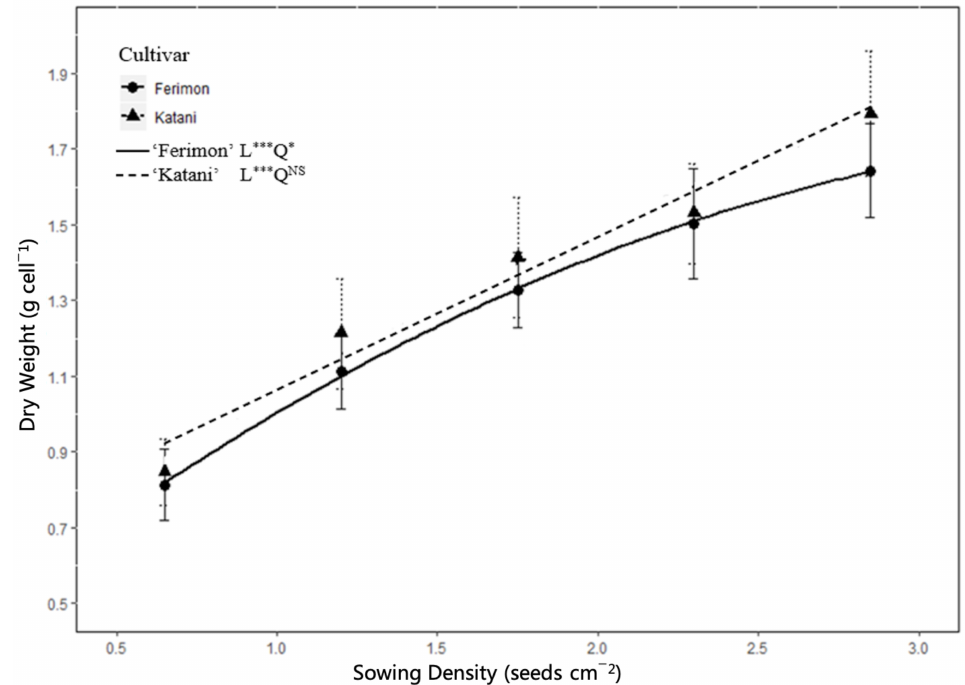
Figure 3. Dry weight per cell of baby leaf hemp ‘Ferimon’ and ‘Katani’ in response to increasing sowing density. Data represent mean ± SE of 15 experimental units (3 crop cycles each with 5 experimental units per treatment per cultivar). Significance of linear (L) and quadratic (Q) regression represented as NS, *, ***, Nonsignificant or significant at p ≤ 0.05 or 0.001, respectively.